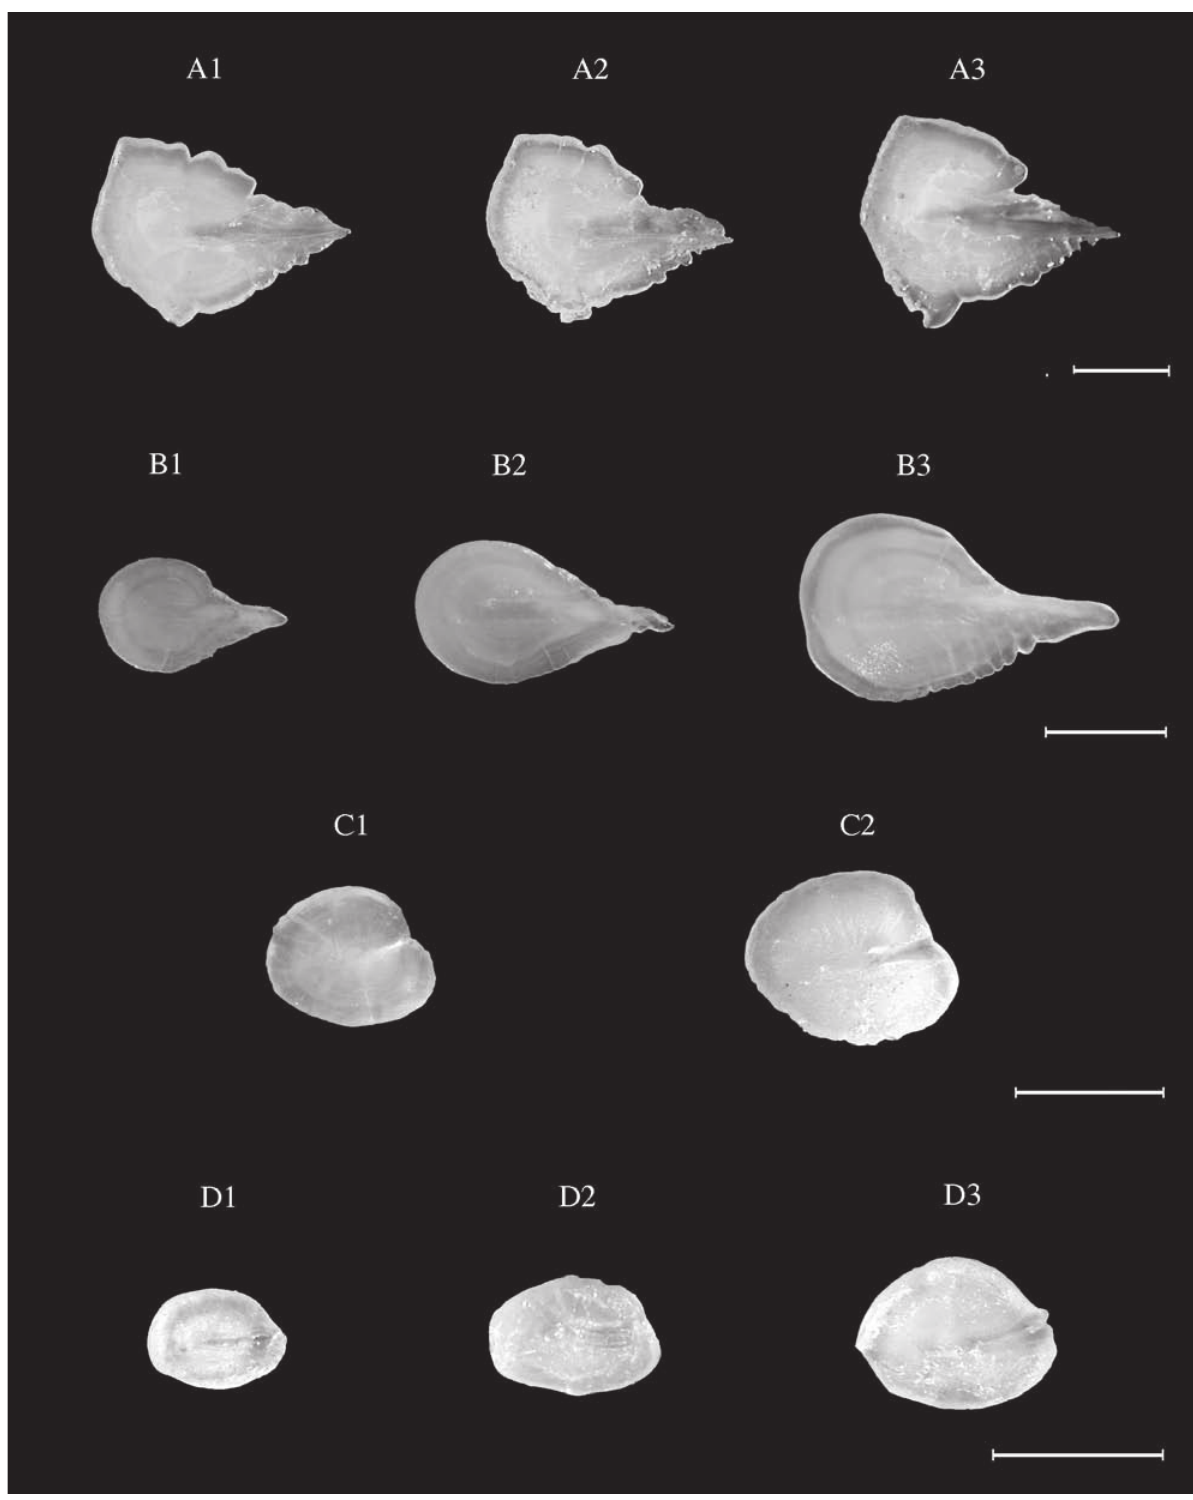
Fig. 19. – Maurolicus muelleri (WM) . TL: A1, 5.0 cm; A2, 5.0 cm; A3, 5.0 cm. Polymetme corythaeola (NEA) . TL: B1, 10.2 cm; B2, 14.2 cm; B3, 16.4 cm. Chauliodus sloani (WM) . TL: C1, 18.5 cm; C2, 23.0 cm. Stomias boa (WM) . TL: D1, 14.0 cm; D2, 19.0 cm; D3, 21.0 cm. Scale bar = 1